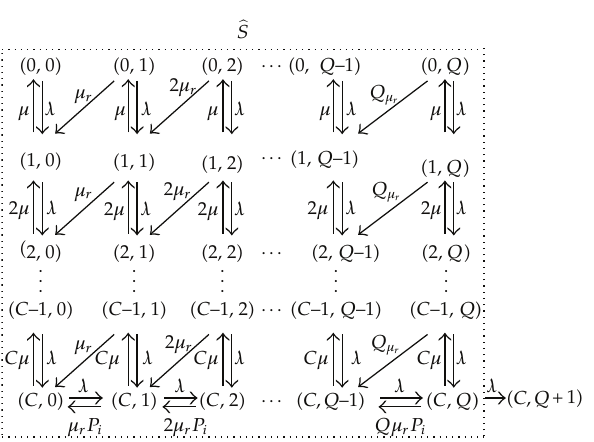
Figure 3: Truncated model and states that appear in Howard equations outside the truncated